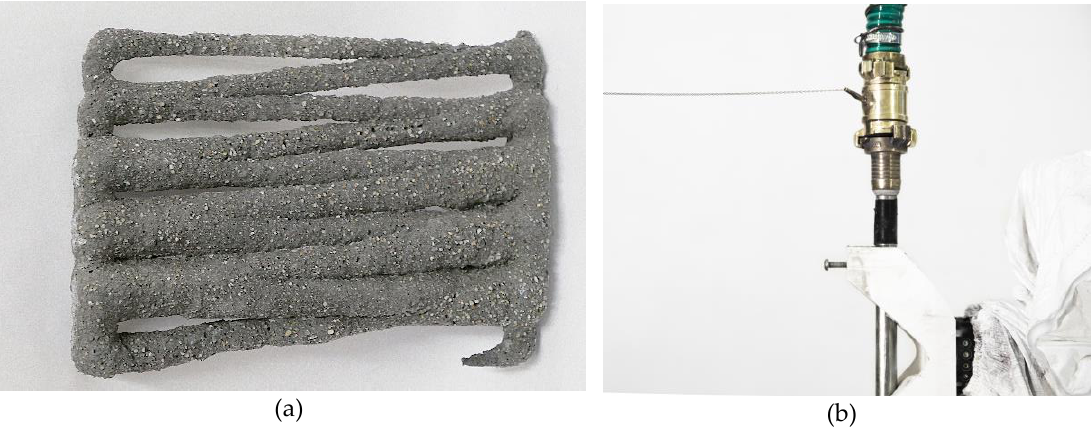
Figure 16. Further investigations: ( a ) differentiated extrusion thickness; ( b ) initial experiments testing the co-extrusion of reinforcement.